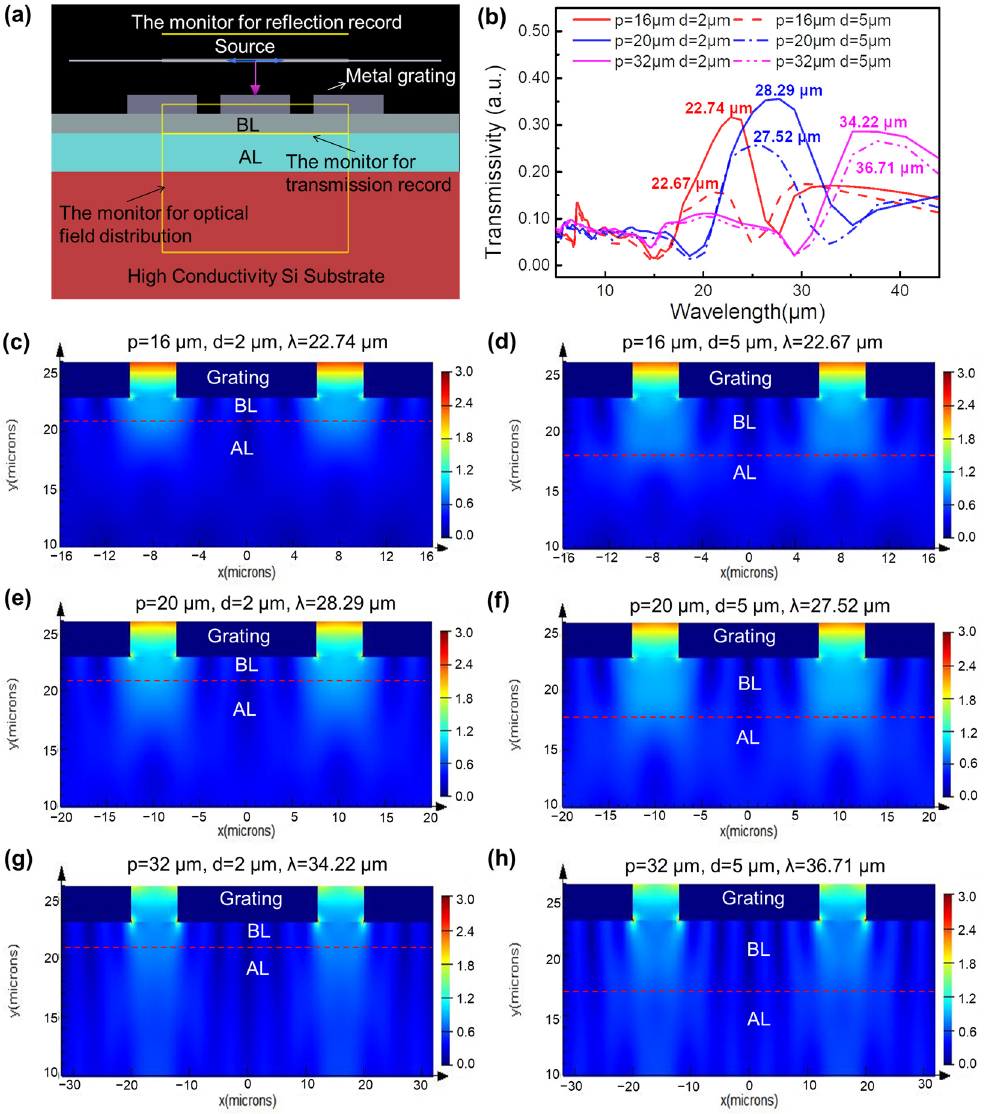
Figure 3. ( a ) FDTD model, ( b ) the simulated transmission spectra of the metal grating/Si-based BIB detector, in which the periods of the metal grating are set as 16, 20, and 32 µ m, and the thicknesses of the BL are 2 and 5 µ m, respectively. The light source, monitors, and the device structure are marked in ( a ). ( c – h ) The optical field distribution of different devices, in which the red dashed lines mark the interface between the AL and the BL.